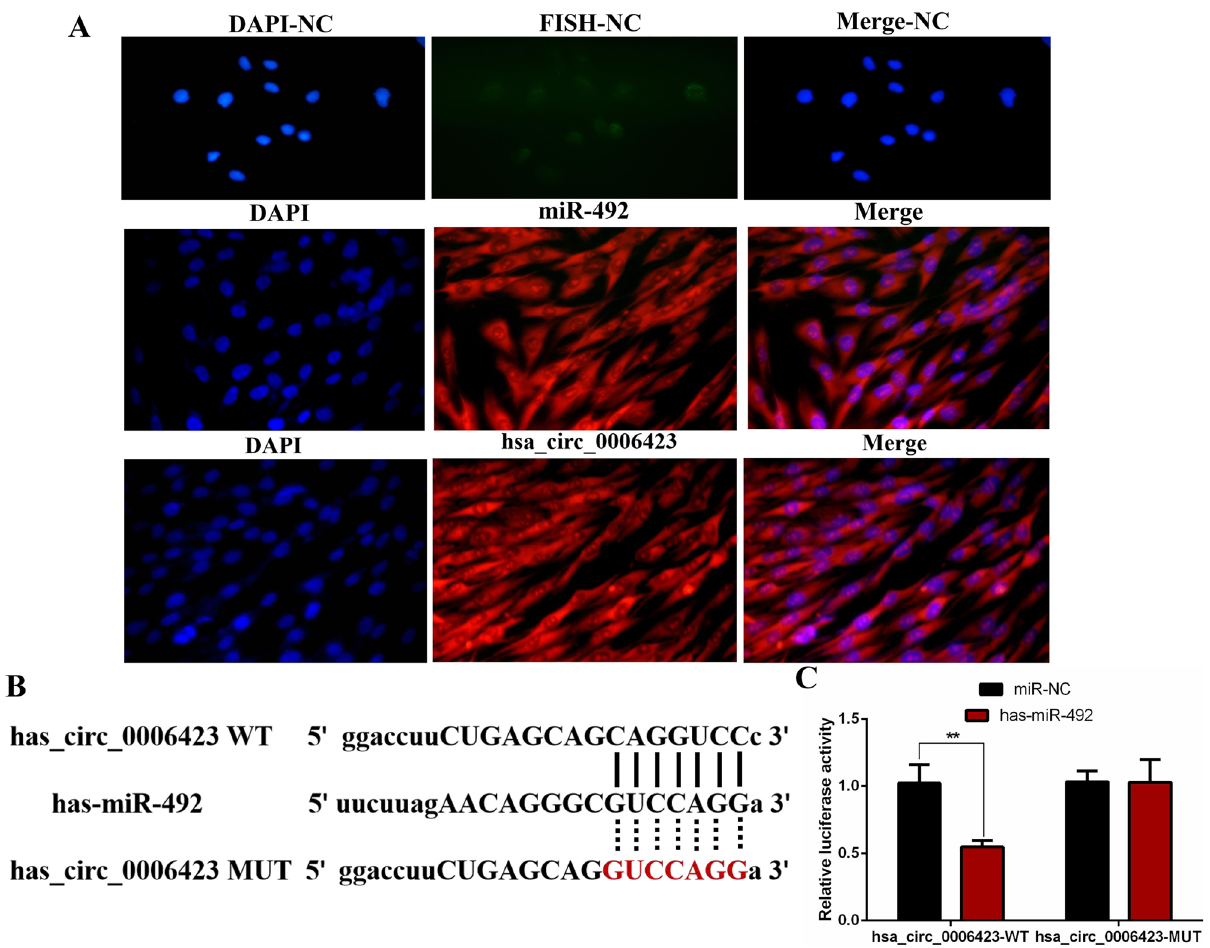
Figure 2. Positioning and sponge of hsa_circ_0006423. ( A ) FISH experiments confirmed that hsa_ circ_0006423 and miR-492 are located in the cytoplasm. The nucleus is labeled with DAPI, hsa_circ_0006423 and miR-492 are labeled with Cy3. Three sets of repeated experiments. ( B ) The potential binding sites of hsa_ circ_0006423 and miR-492. ( C ) The luciferase reporter gene experiment confirmed the combination of miR-492 and wild-type hsa_circ_0006423. NC negative control. ** P <